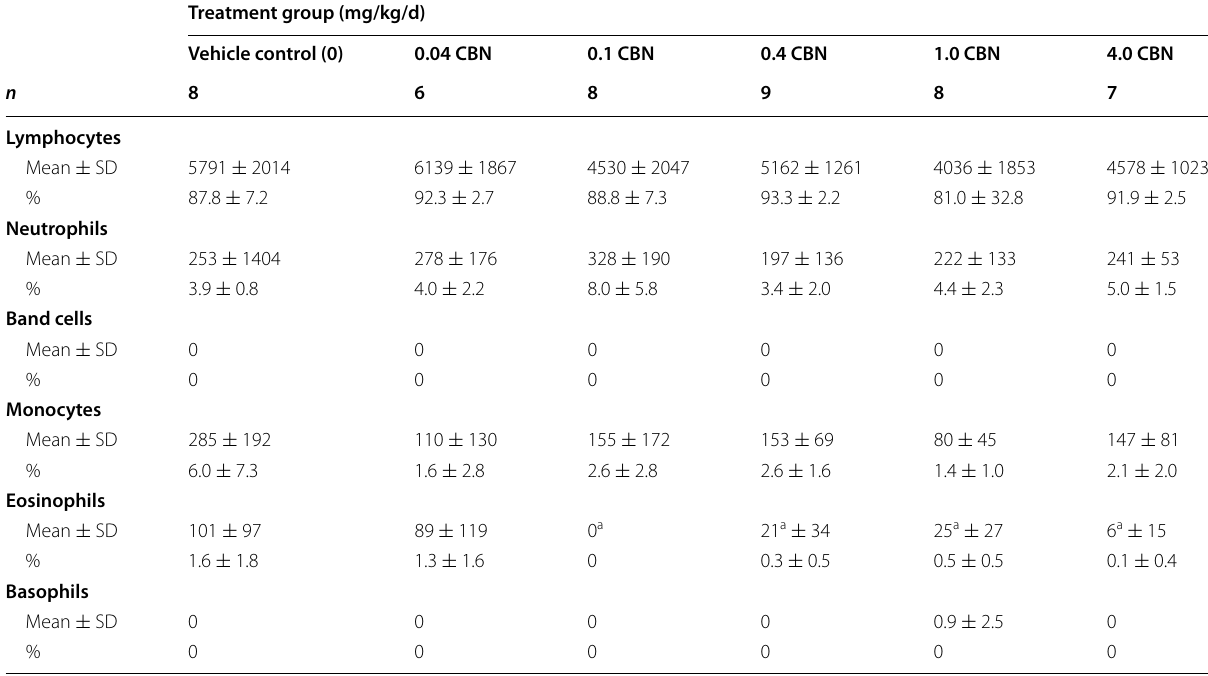
a Differs significantly from control and 0.1 mg/kg/d CBN treatment groups. CBN , cannabinol; CBNT , CBNight ™ ; d , day; kg , kilogram; mg , milligram; SD , standard deviation Table 5 Effect of CBNT on blood chemistry in mouse blood samples without hemolysis